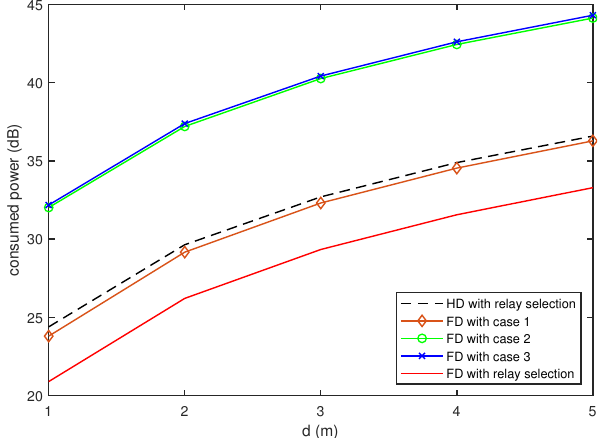
Figure 4. Comparison of power consumption as a function of d ( ρ th = 0.5).